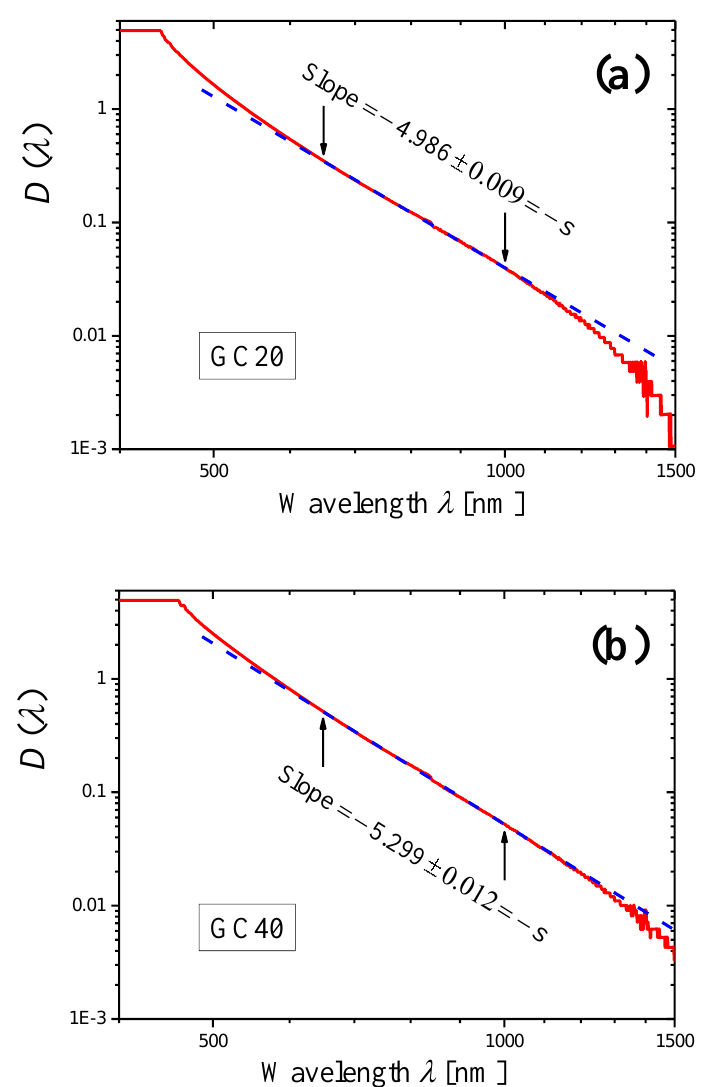
Figure 10. Log–log plots of the internal optical density D ( λ ) (red curves) for samples of the glass- ceramics GC20 ( a ) and GC40 ( b ). The samples have the same thickness h = 2.00 mm. The portion of each curve limited by arrows is approximated by red dashed straight line using the least squares method, and the slope of the straight line is indicated in the